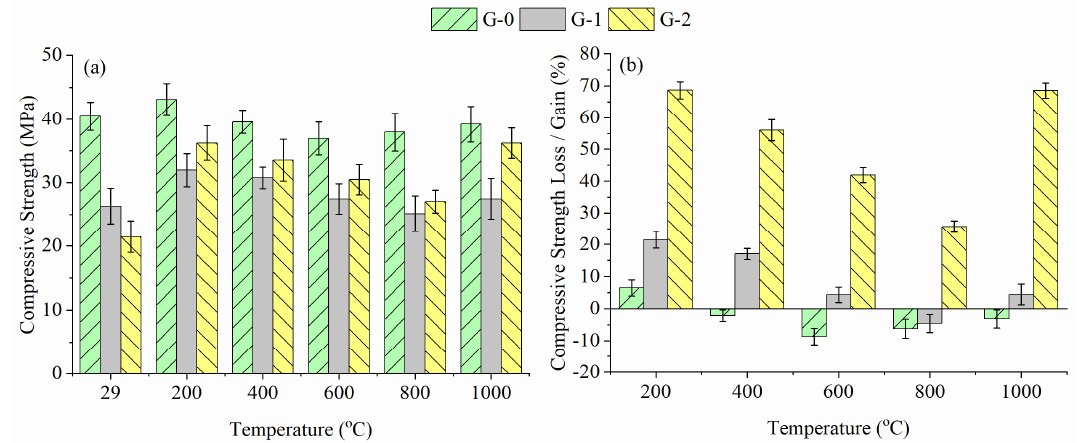
Figure 9. ( a ) Compressive strength and ( b ) strength changes of G-0, G-1 and G-2 with respect to unexposed samples.